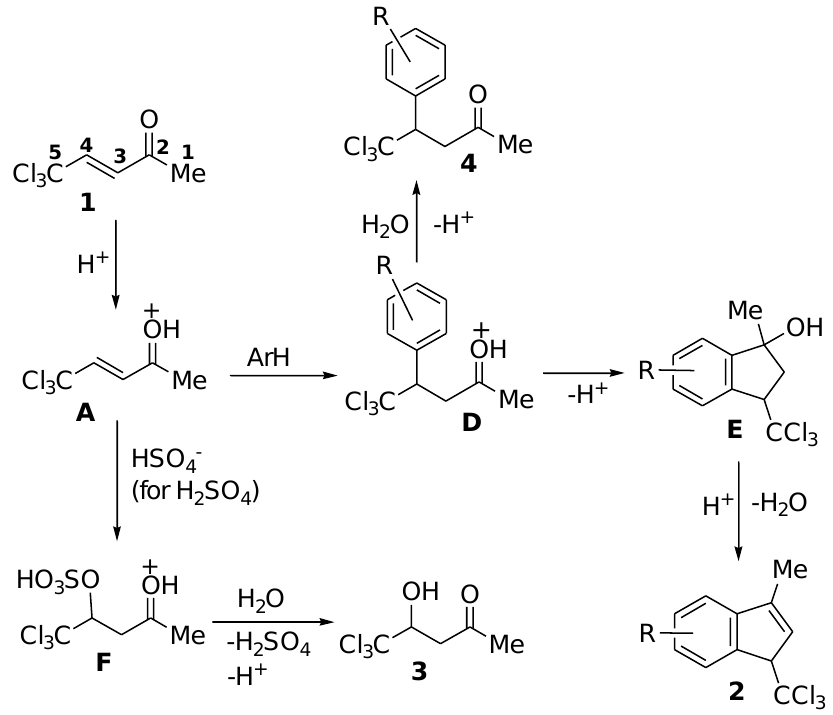
Scheme 4. Plausible reaction mechanisms for transformations of CCl 3 -enone 1 in Brønsted acids.